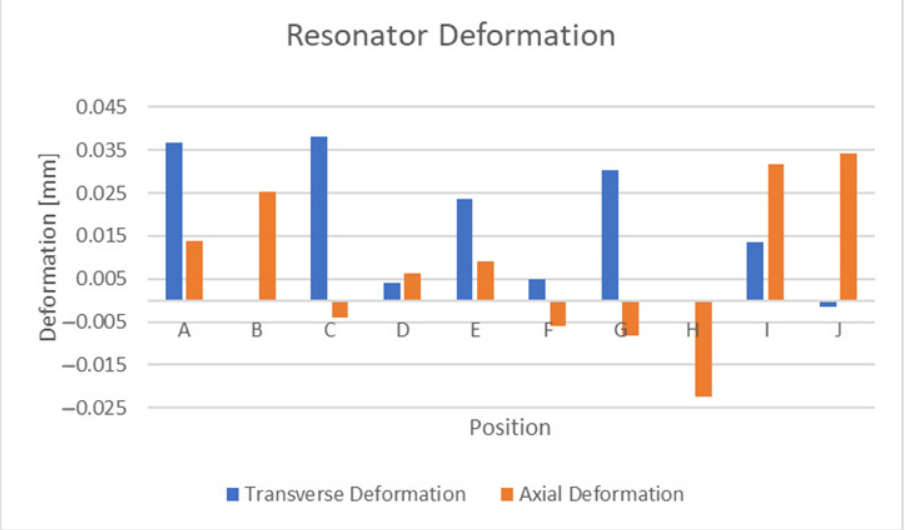
Figure 17. Thermal expansion deformations at 350 °C.